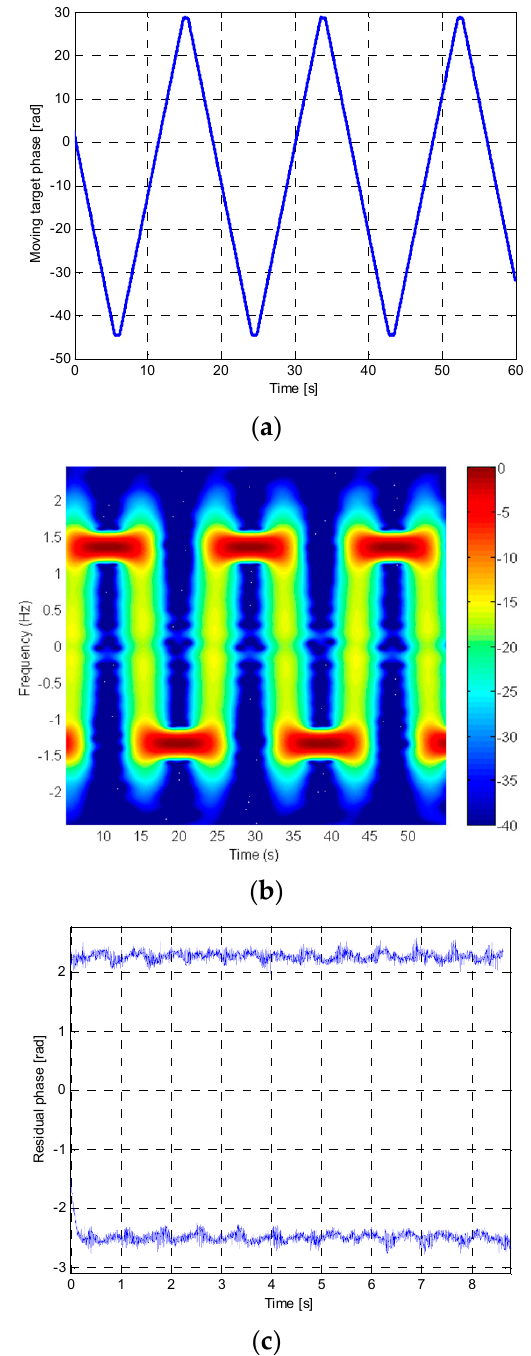
Figure 7. Analysis of the moving target signal. ( a ) Phase versus time; ( b ) Doppler frequency versus time (colorscale in dB, normalized to the maximum); ( c ) Residual phase after linear motion compensation.